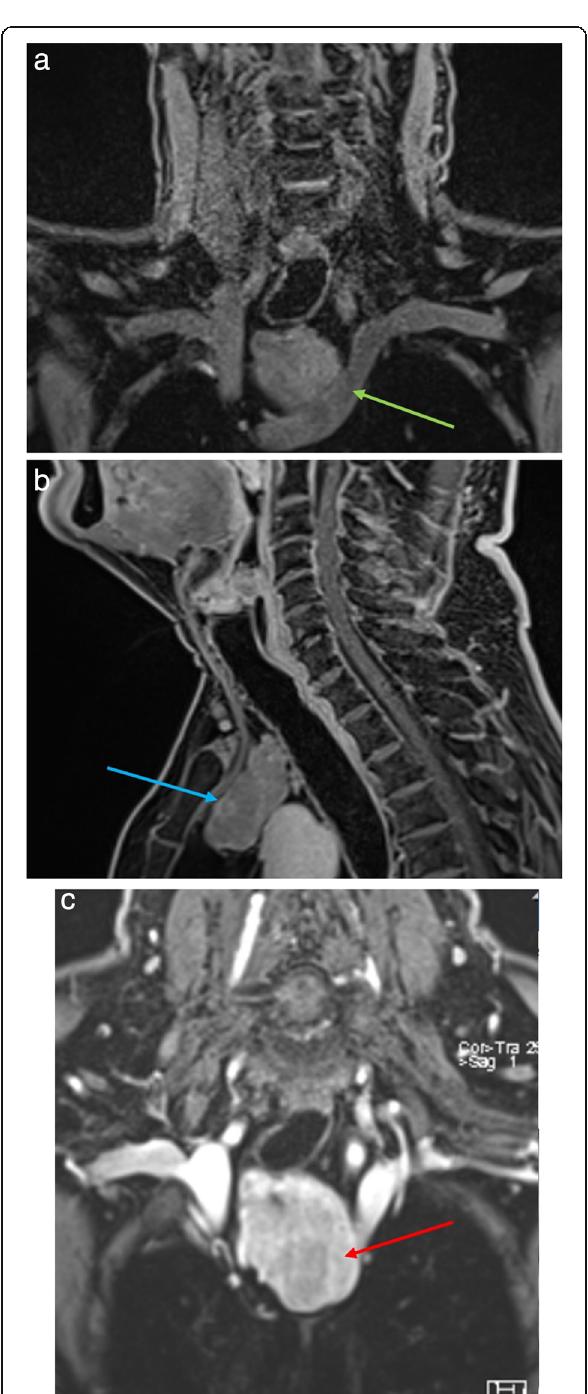
Fig. 3 Coronal T1 Dixon ( a ); Sagittal T1 Vibe Dixon ( b ) and coronal T1 after gadolinium ( c ) demonstrating a well-circumscribed, heterogeneously enhancing tissue (red arrow), at the level of the anterior mediastinum, at pre-vascular space (blue arrow). The lesion is well demarcated from the adjacent mediastinal structures, with slightly displacing and compression of left venous brachiocephalic trunk (green